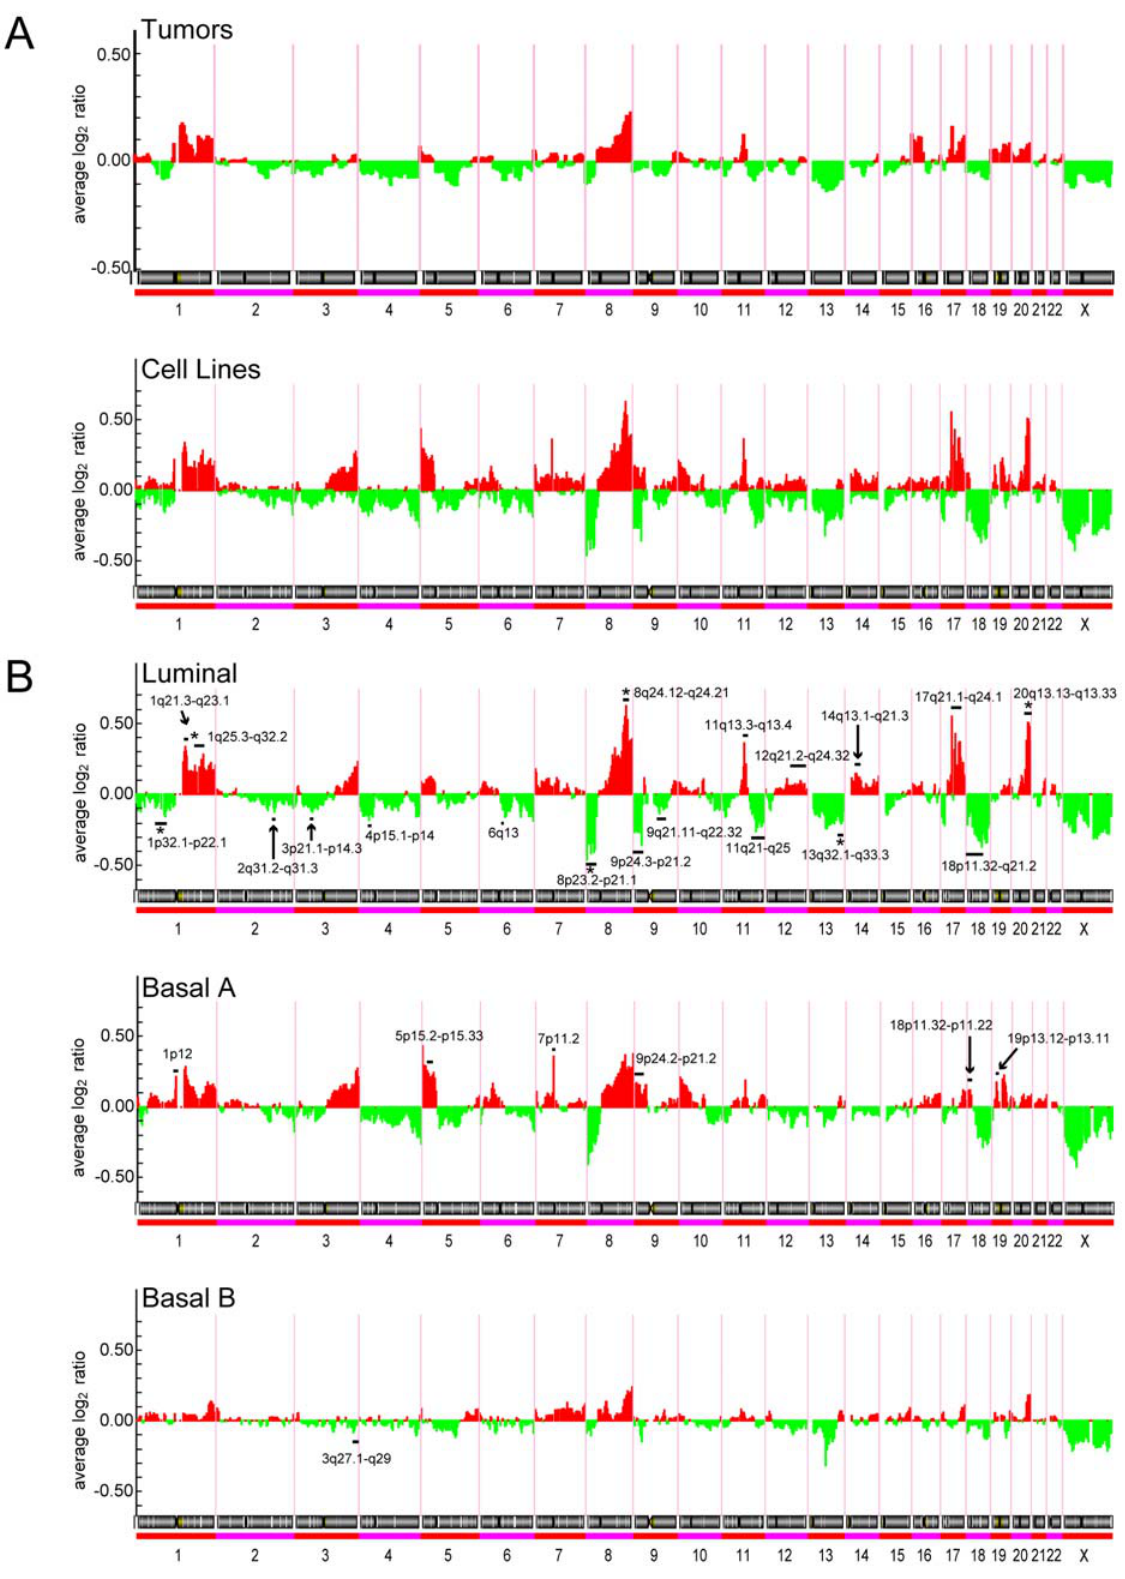
Figure 3. Genomic profiles define spectra of CNAs in cell line subtypes. (A) Spectra of gains (red) and losses (green) across the genome, plotted as average log 2 ratio, for 89 breast tumors [4], above, compared to the set of 50 cell lines (profiled for both expression and CNAs), below. (B) Spectra of gains and losses for the cell line subtypes: luminal (above), basal A (middle) and basal B (below). Statistically significant subtype-specific CNAs, called by SAM (FDR , 5%), are marked by a black bar. The subset of those loci that also characterize the corresponding primary breast tumor subtype is marked by an asterisk. doi:10.1371/journal.pone.0006146.g003 PLoS ONE |